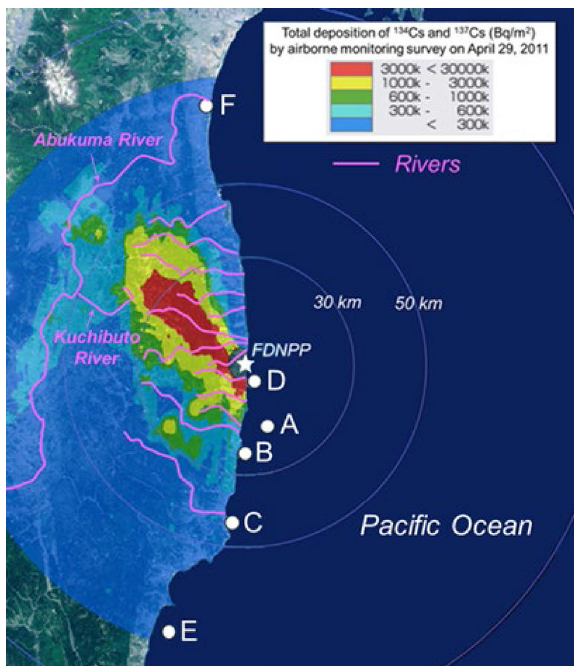
Figure 1. Sampling points A–F and rivers near the FDNPP, shown on a Cs inventory map from MEXT 40